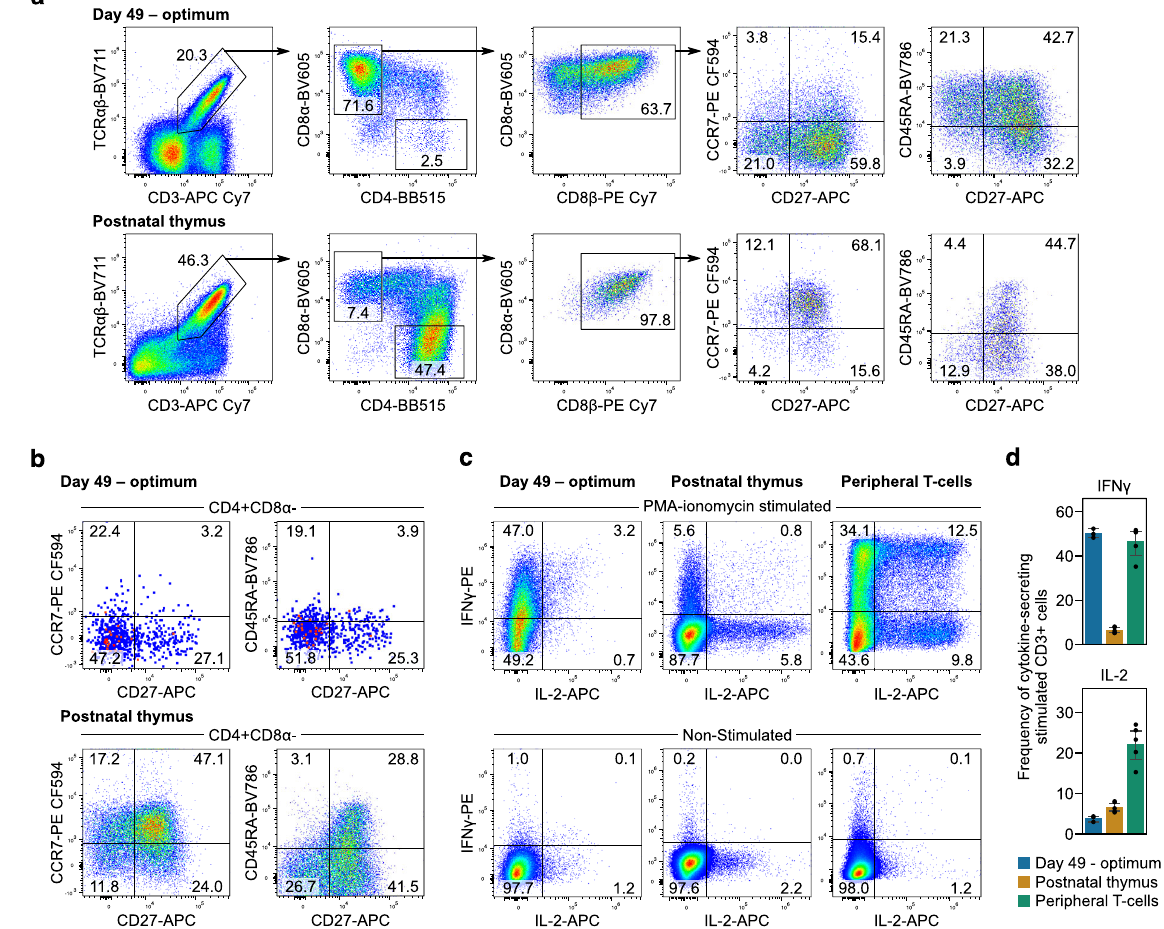
Fig. 6 Generation of conventional T-cells that secrete cytokines. a Nonspeci fi c TCR stimulation using anti-CD3 monoclonal antibodies with IL-2 administration induced maturation of DP to CD8SP T-cells. These cells predominantly expressed CD8 αβ heterodimers and high levels of CD27 and CD45RA. A smaller proportion of CD8SP expressed CCR7 than postnatal thymocytes. b A small population of CD4SP T-cells were present and fewer of these cells expressed CD27 and CCR7 than ETN-generated CD8SP or CD4SP postnatal thymocytes. Shown are means from n = 3 UCB donors and n = 3 postnatal thymus donors. c Further stimulation using PMA and ionomycin resulted in secretion of IFN γ with some cells also secreting IL-2. Fewer postnatal thymocytes secreted IFN γ than generated T-cells and none secreted both IFN γ and IL-2. Peripheral T-cells secreted high levels of both IFN γ and IL-2. d The frequency of IFN γ secreting cells was comparable between ETN-generated and peripheral T-cells and markedly greater than postnatal thymocytes. The frequency of IL-2 secreting cells was much lower in ETN- generated T-cells and postnatal thymocytes than peripheral T-cells. All cytokine secretion is from viable CD3 + cells. c , d from n = 3 UCB donors. One donor each of postnatal thymocytes and peripheral T-cells are shown with n = 5 technical